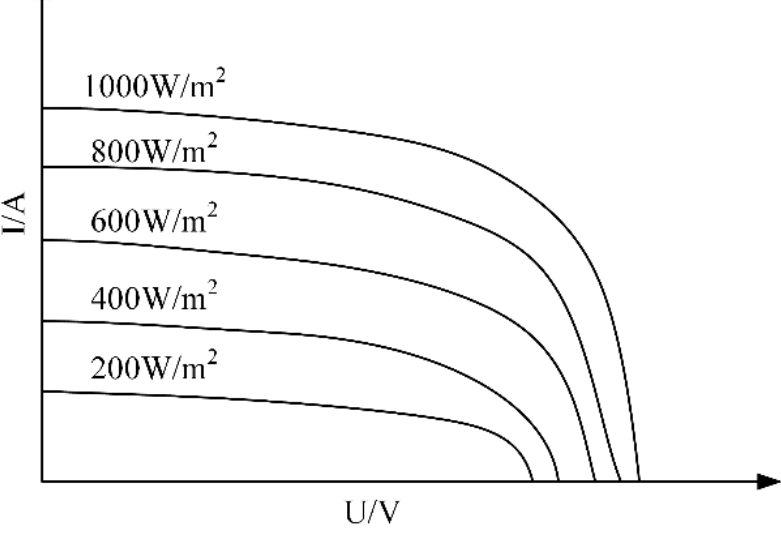
Figure 6. U-I characteristic curves of solar array under different light intensity. Figure 6. U ‐ I characteristic curves of solar array under different light intensity. The abnormal discharge of the solar array can be caused by the space plasma envi- ronment and high-speed impact. The flash effect usually occurs simultaneously with the plasma effect, which is the generation of energy radiation by material in a high-speed impact. This process affects the incident light intensity [29], causing non-linear changes in the output of the solar array. As shown in Figure 7, the operating point of the solar array migrates when the light intensity increases, which is caused by the arc discharge and accompanying flash effect. In steady-state conditions ( t 0 – t 1 ), the output of the solar array is equivalent to a constant current, I o . When the light intensity increases from 1000 to 2000 W/m 3 at t 1 , the current operating point increases from I o to I 1 in the U-I curve. There- fore, the output current I SA of the solar array varies non-linearly, which is an unexpected large current spike generated during the discharge